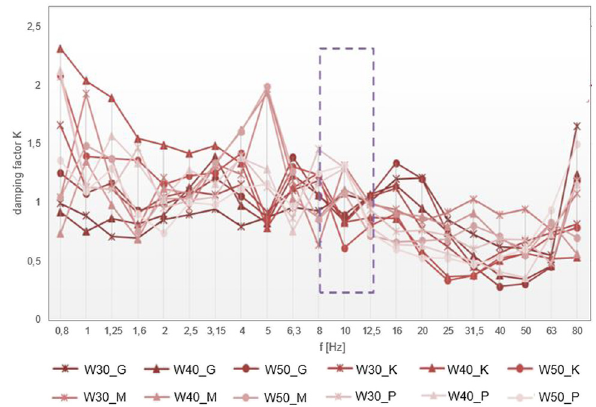
Figure 12: The damping coe ffi cient K ( “ Z ” direction ) when driving on a cube “ bone ” surface with a universal wheelchair with the use of polyurethane foam of three thicknesses, markings: W30 – thickness of the spacer layer 30 mm, W40 – 40 mm, W50 – 50 mm; G, K, M, P – markings of